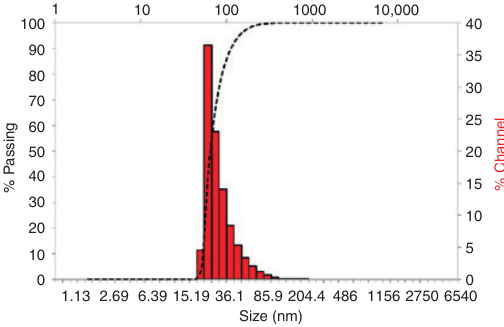
Figure 6: Particle size distribution of synthesized AuNPs at obtained optimum synthesis conditions.